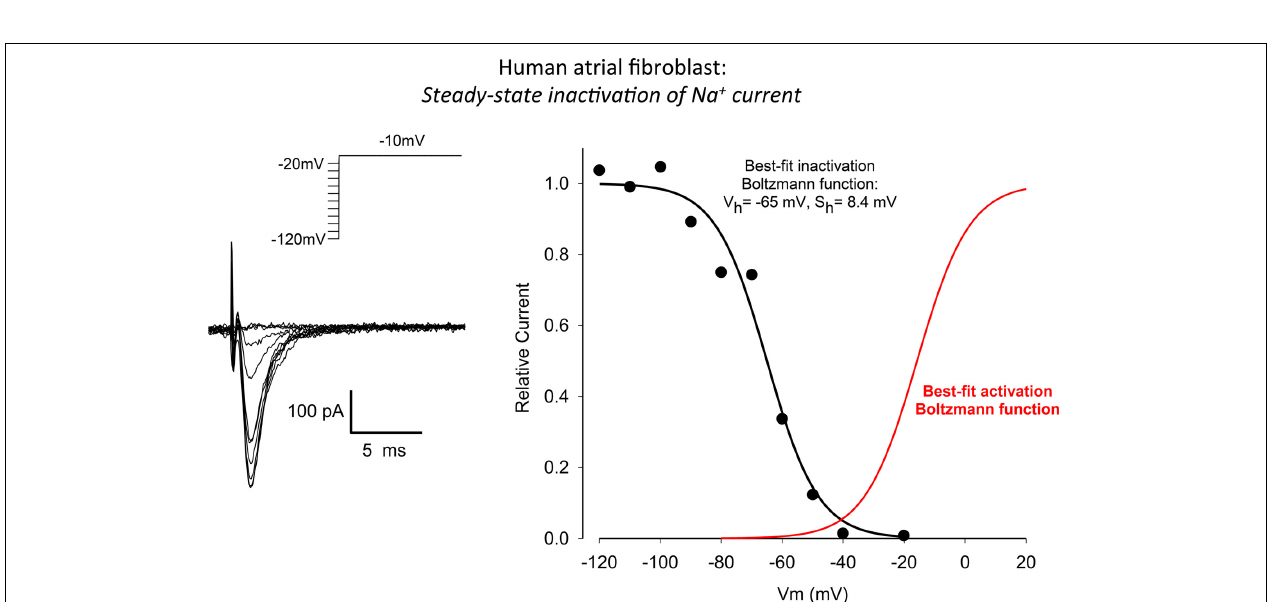
the right-hand panel is an I–V curve. It was constructed by plotting the peak inward current at each selected voltage clamp depolarization level. The patch pipette solution in this experiment was Cs + -rich (Methods), to block the large and rapidly activating I K − Ca , which obscured I Na at potentials positive to about + 30mV (see Figure 1 and text in Results).